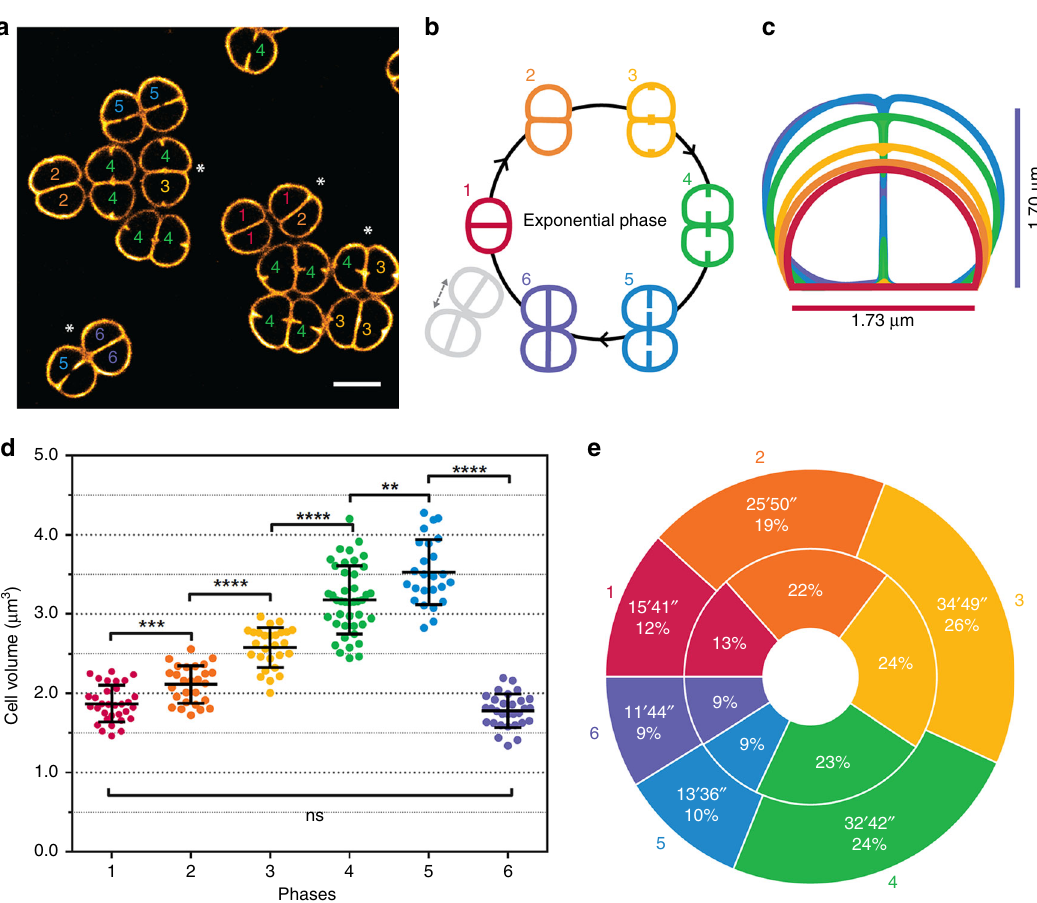
Fig. 1 Morphological changes occurring during the growth of D. radiodurans . a PAINT imaging of live D. radiodurans cells stained with the membrane dye Nile Red. Numbers inside each cell correspond to their growth phase shown schematically in b . Diads marked with an asterisk are composed of two asynchronized cells. Scale bar: 2 µ m. b Schematic representation of the different phases of the D. radiodurans cell cycle in exponentially growing bacteria. c On-scale representation of the average cell sizes and morphologies at the different phases of the cell cycle coloured as in b . Phase 6 cells are very similar to Phase 1 cells. d Changes in cell volume during the cell cycle ( N = 185 cells, N > 25 for each phase). Data are represented as mean ± SD. Individual values are shown as dots. Cell volumes were calculated by measuring the cell parameters on PAINT images of exponentially growing wild-type D.